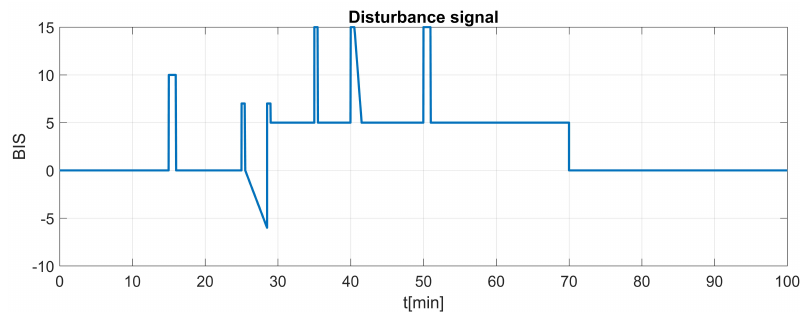
Figure 16. Artificial disturbance signal.